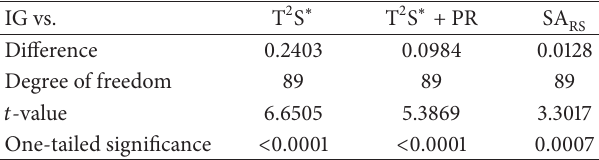
Table 9: Paired 𝑡 -tests on the average RER for new problem